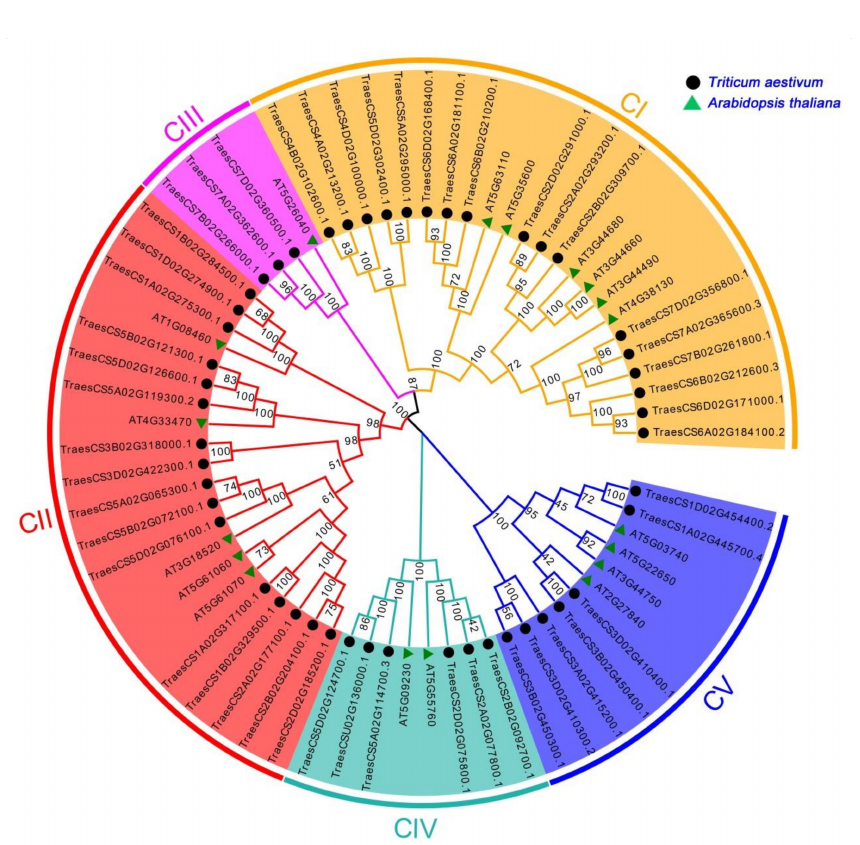
Figure 1. Phylogenetic relationships among histone deacetylase (HDAC) proteins in Triticum aestivum and Arabidopsis thaliana . All HDAC proteins were allocated into 5 clades. Orange, red, purple, cyan, and blue represent C I, C II, C III, C IV, and C V, respectively. The unrooted tree was established by the neighbor-joining (NJ) method using the MEGA7.0 software with 1000 bootstrap